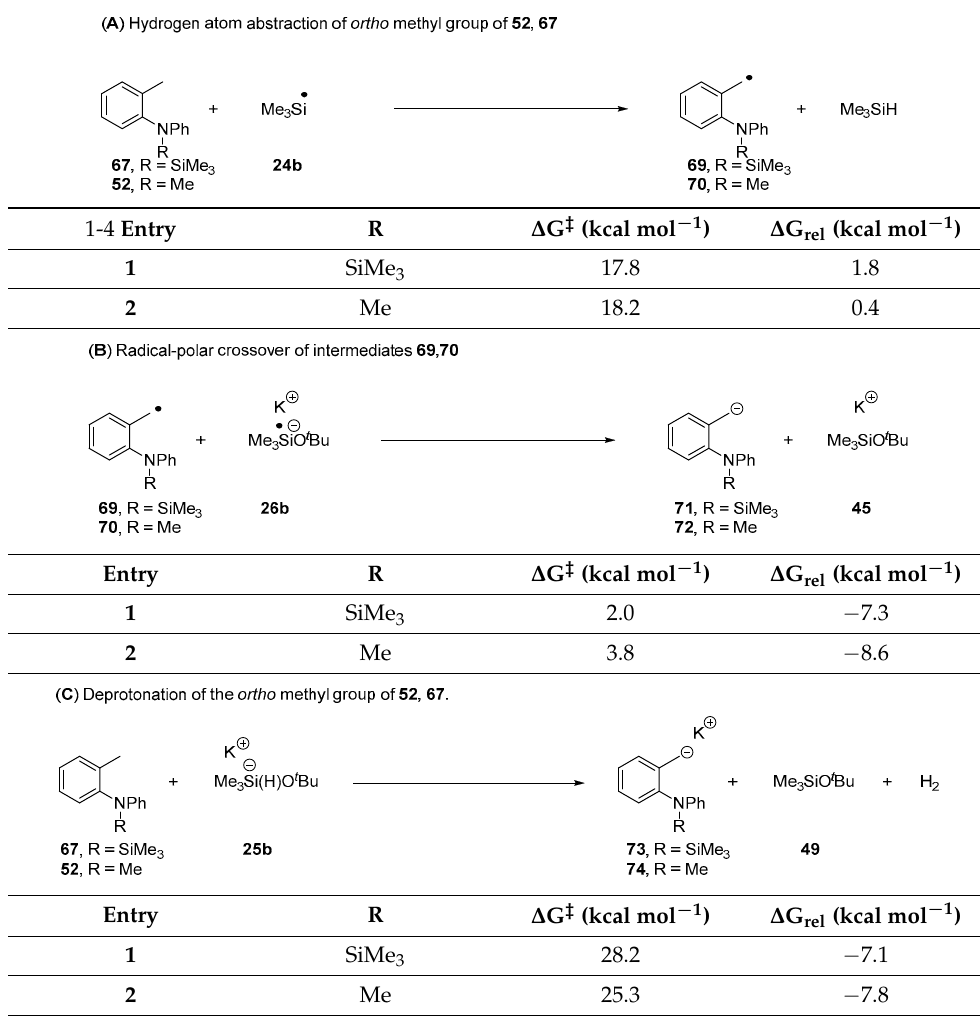
Figure 1. Additional o -tolyl aryl amine substrates investigated. Cyclisation of substrate 67 was studied via both benzyl radical and benzyl anion intermediates and the energy profiles for formation of these intermediates are shown in Table 1. The initial hydrogen atom abstraction of the ortho methyl by a trimethylsilyl radical 24b has attainable activation energy (17.8 kcal mol −1 ) and is almost thermoneutral (entry 1, Table 1A). Table 1. Investigation into ( A ) the hydrogen atom abstraction facilitated by 24b , ( B ) the radical-polar crossover mediated by 26b , and ( C ) direct deprotonation of the ortho methyl group via pentavalent silicate 25b for substrates 65 and 58.